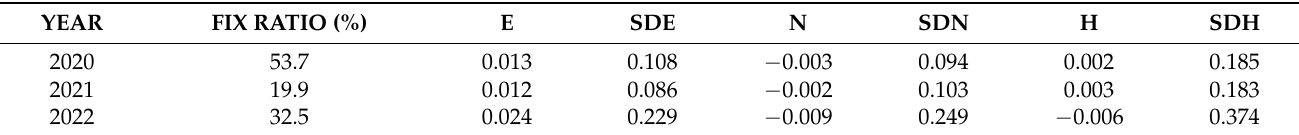
Table 4. The first column contains the years of the available records (hourly POS files with a sampling rate of 1 s). The second column shows the FIX percent (the availability of a FIX solution is an indicator that the determined position is reliable) of reliable solutions estimated for each year. The low fix percentage was due to (1) the experimental regime of the UDI2 station with some long data interruptions, resulting in the absence of the differential data from the UDI2 station; (2) the percentage of solutions with unresolved ambiguities (FLOAT condition); and (3) the fact that all positions with fixed ambiguities but with less than 10% available solutions are discarded within an hour, as this condition is synonymous with poor reliability. Columns 3, 5, and 7 show, respectively, the differences between the mean values of the north–south, east–west, and vertical (E, N, and H) coordinates (EPSG: 32632–WGS 84/UTM zone 32N) estimated for each annual dataset and the reference coordinates obtained in a post-processing calculation using data from the first hour of acquisition. Columns 4, 6, and 8 show the relative standard deviation (DE, DN, and DH). All the reported quantities are in